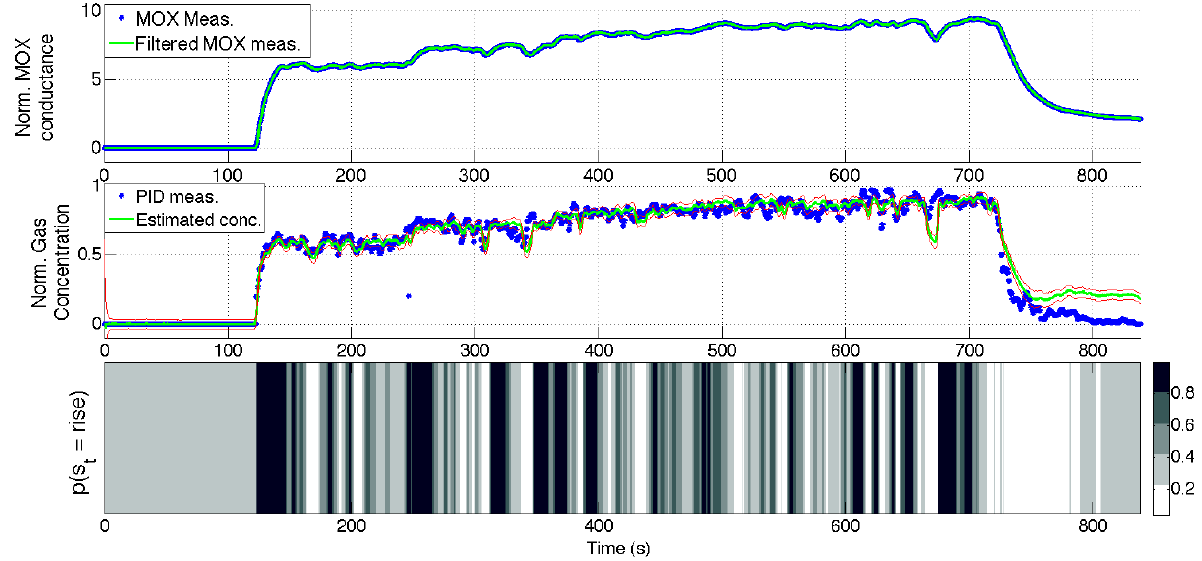
Figure 11. aSLDS inference results for an experiment of dataset Ascending Stairway . ( Top ) MOX measurements, ( Middle ) Gas concentration, ( Bottom ) Sensor phase probability distribution.